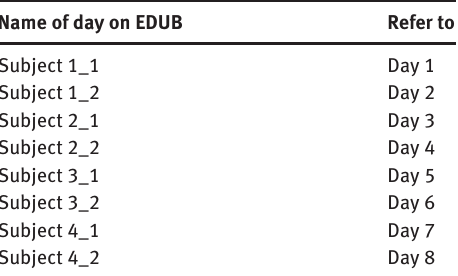
Table 1: Correspondence between subject and days.